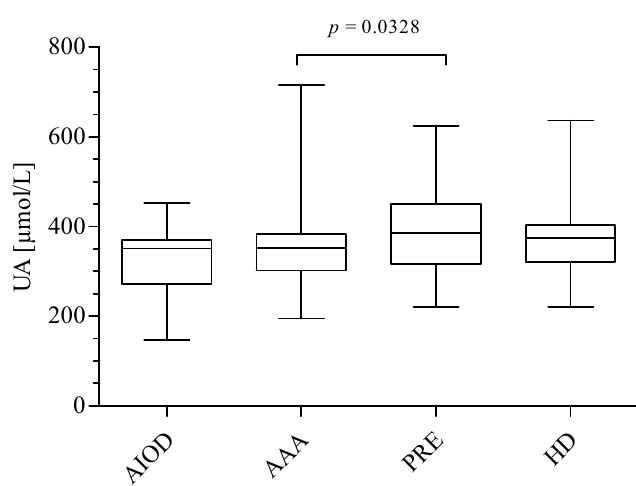
Figure 4. Uric acid (UA) concentration in the studied groups expressed as µ mol / L. The Kruskal–Wallis test, followed by Dunn’s Multiple Comparison Test, were used to compare the studied groups.